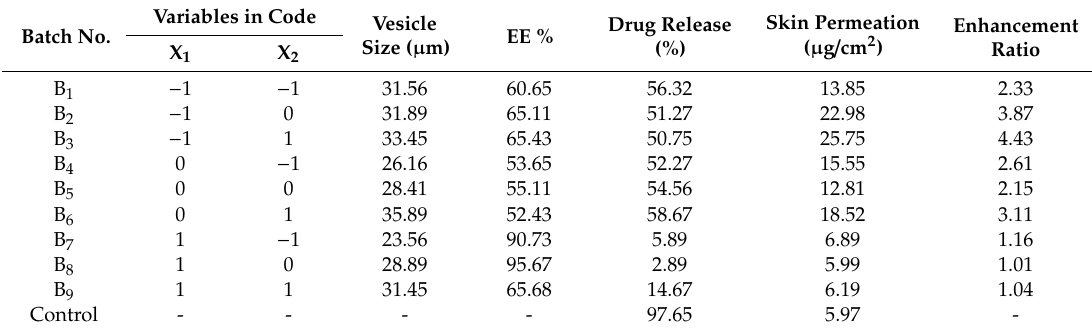
Table 14. Formulation composition, vesicle size, entrapment e ffi ciency (EE%), drug release (%), skin permeation ( µ g / cm 2 ) and enhancement